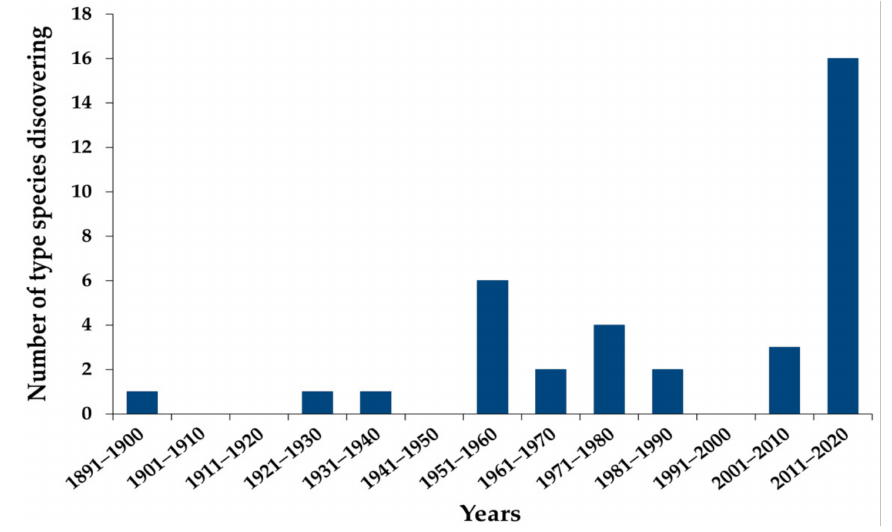
Figure 1. The discovering of Wickerhamomyces type species since 1891 till the present time.